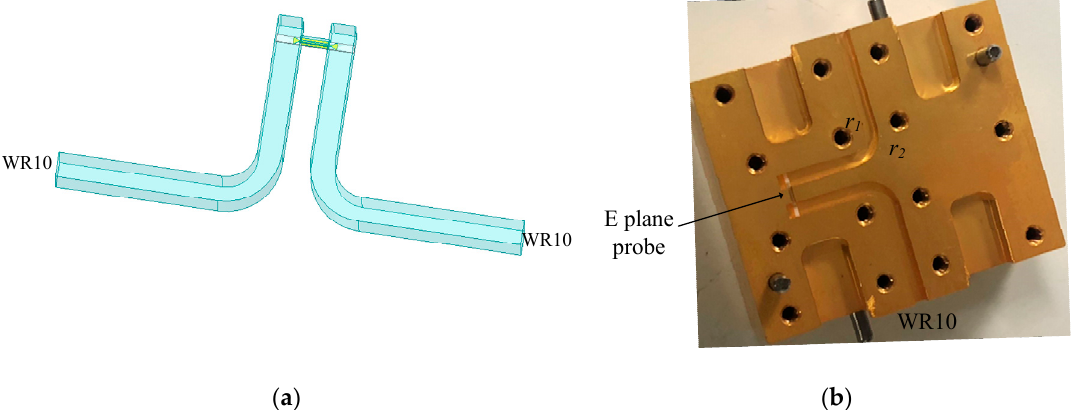
Figure 3. Back-to-back photograph of the transition. ( a ) Simulated configuration; ( b ) fabricated photograph (the upper layer is hidden).